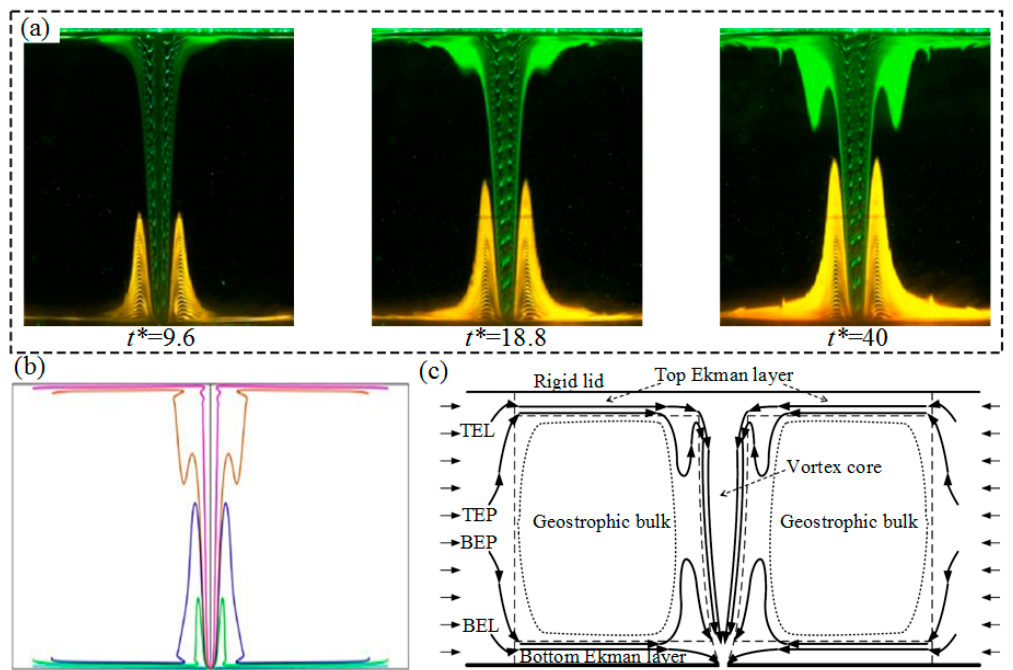
Figure 2. The evolution process of the Ekman layer ( t * represents the normalized time). ( a ) Flow visualizations of steady vortexes. ( b ) Streamline on meridional r–z planes. ( c ) Flow pattern sketch. (Reprinted with permission from Ref. [54]. 2013, Cambridge University Press).